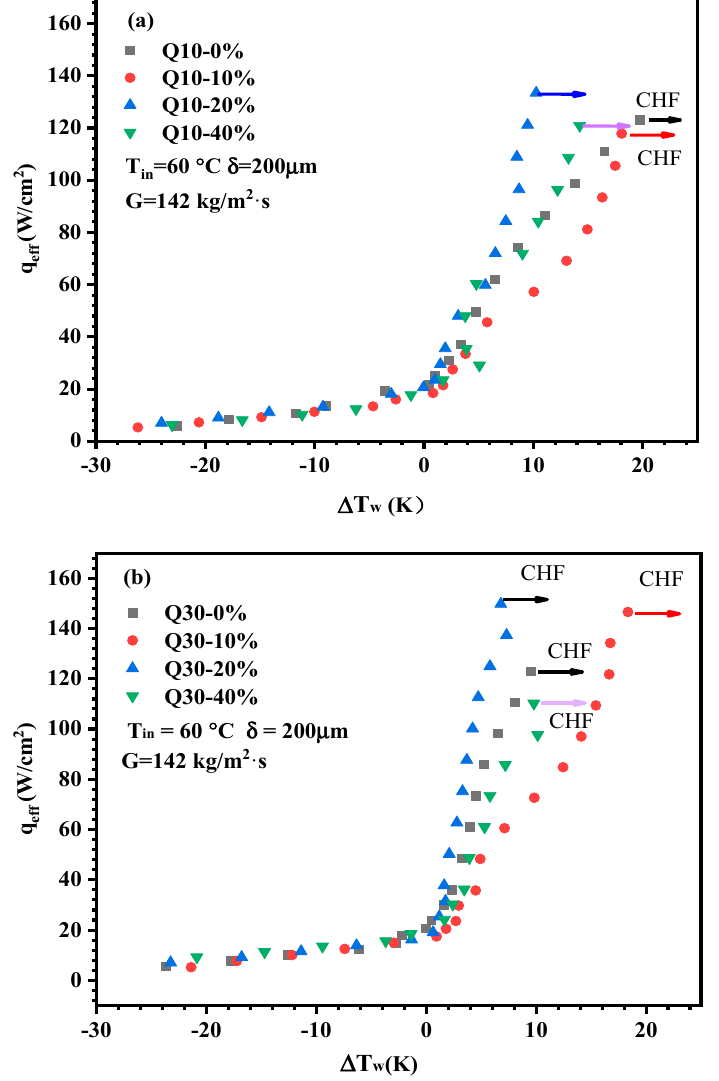
Figure 7. Boiling curves of porous-microchannel samples with different PFA contents. ( a ) Q10-series; ( b ) Q30-series.